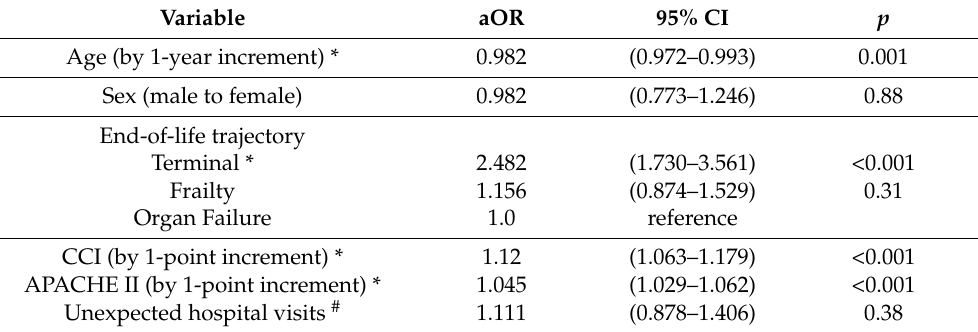
Table 4. Binary logistic regression analysis of clinical predictors for 90-day inpatient